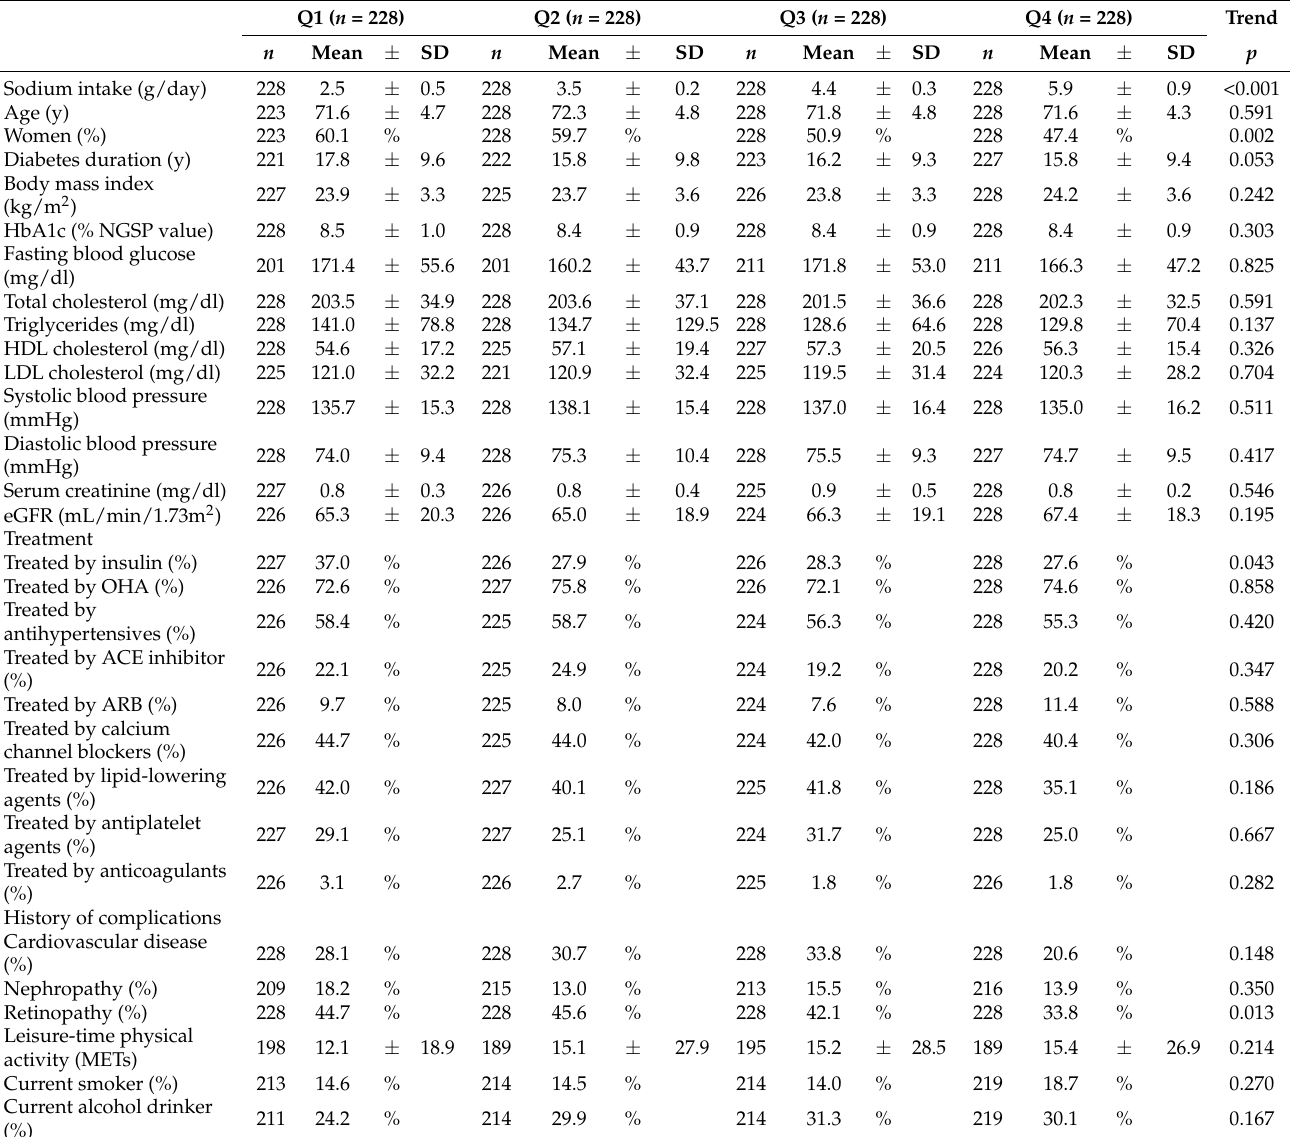
Table 1. Baseline clinical characteristics of the 912 elderly patients with type 2 diabetes according to quartiles of sodium